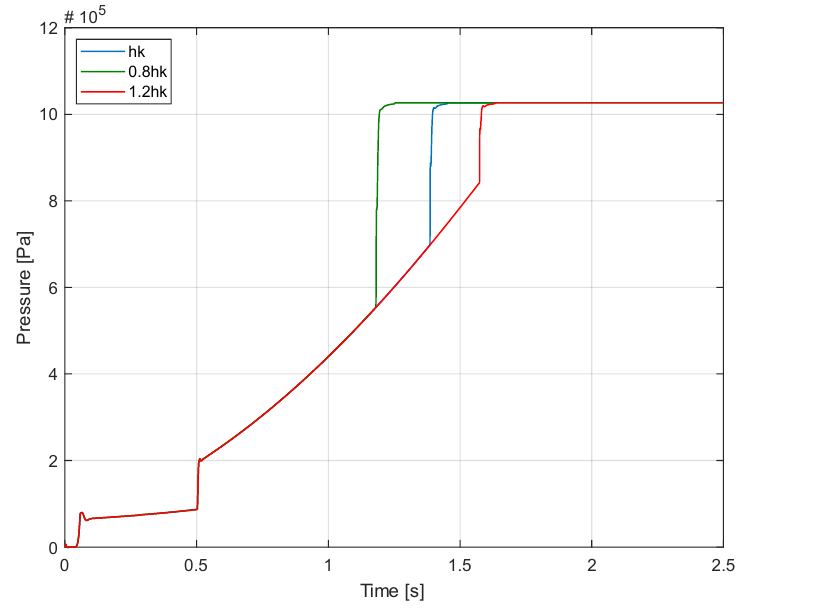
Figure 15 – Influence of the distance between the piston (a) and the piston (b) on the pressure modulation